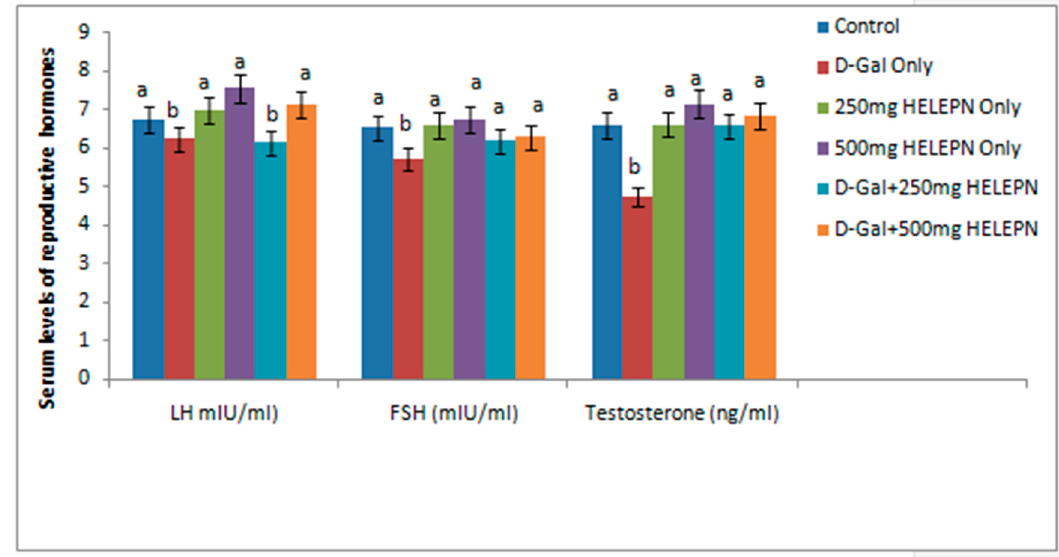
Figure 2. Effect of graded doses of HELEPNon reproductive hormones.Values are means of five replicates ± SEM. Bars carrying different superscripts (a, b) are significantly different at p < 0.05.